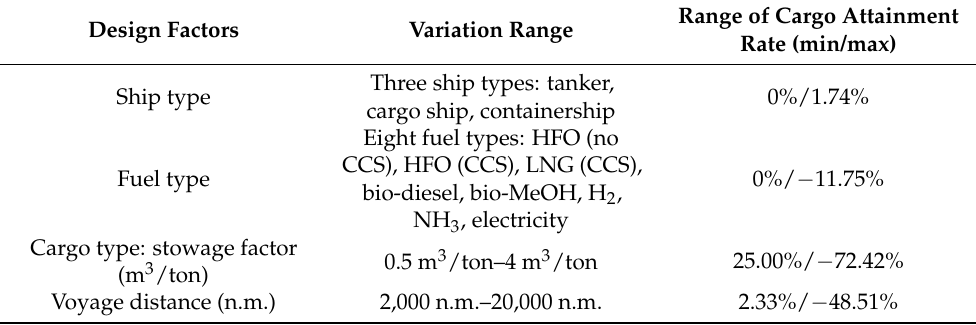
Table 2. The range of cargo attainment rate relative to an HFO-fuelled containership without CCS carrying cargo with a stowage factor of 1.25 m 3